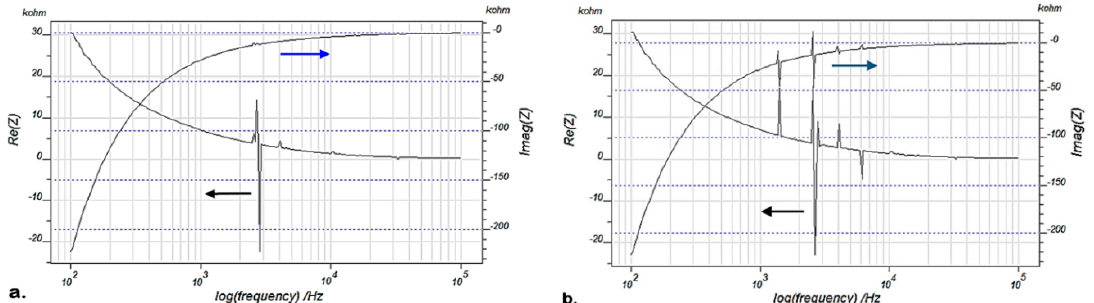
Figure 3. EMI frequency spectrum of sensor A bonded to the aluminum plate at ( a ) 200 °C, and ( b ) 20 °C using the transceiver (flat segments with no peaks have been neglected).